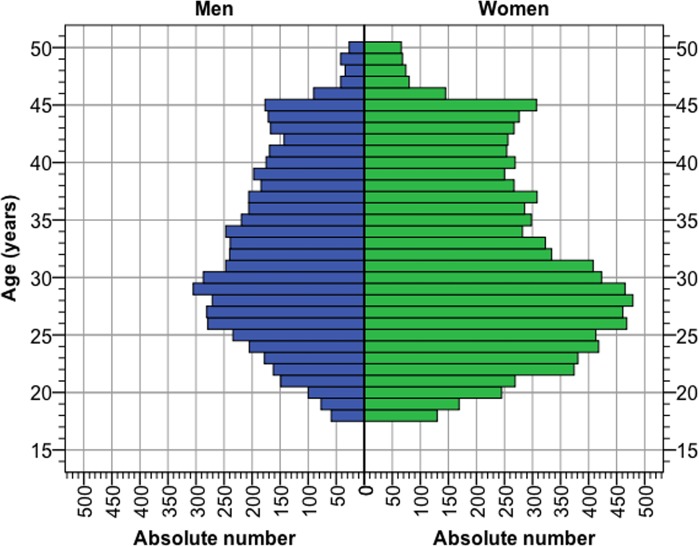
Age distribution of the study population stratified by sex.